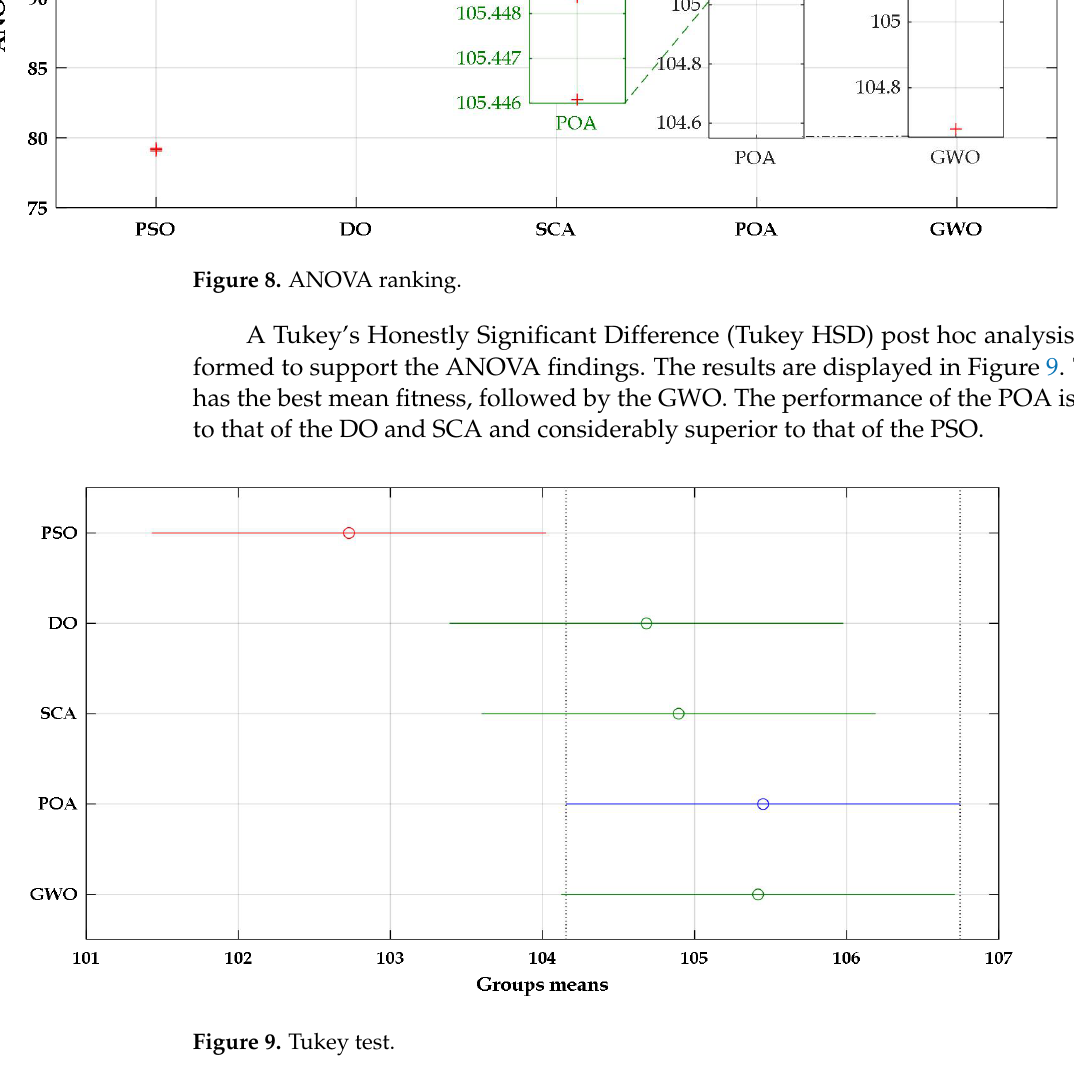
Table 6. Optimum parameter values using the considered